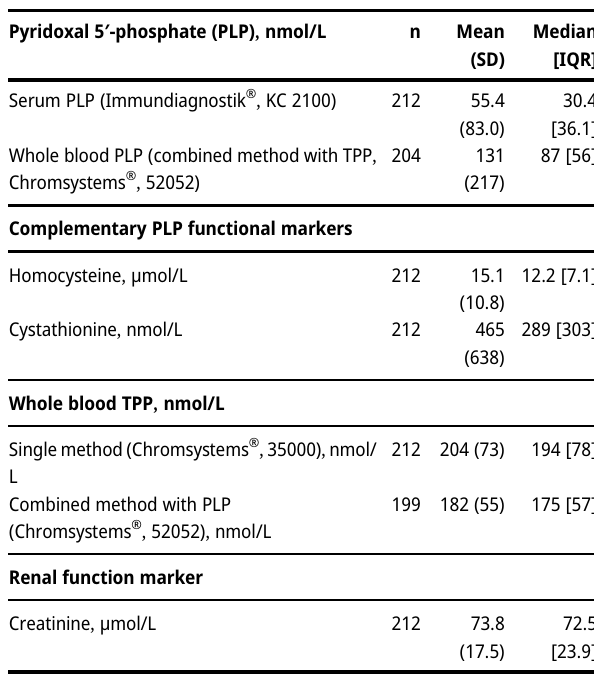
Table  : Descriptive results of concentrations of PLP in serum and whole blood, PLP metabolic markers, TPP, and creatinine.